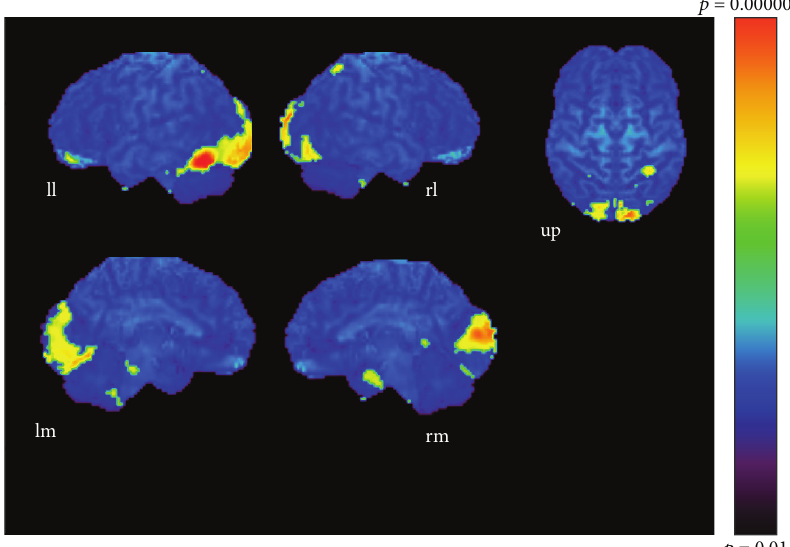
Figure 3: Simple-chord condition ( 𝑝 < 0.001 ). ll: lateral surface of left hemisphere; lm: medial surface of left hemisphere; rl: lateral surface of right hemisphere; rm: medial surface of right hemisphere; up: upper surface.